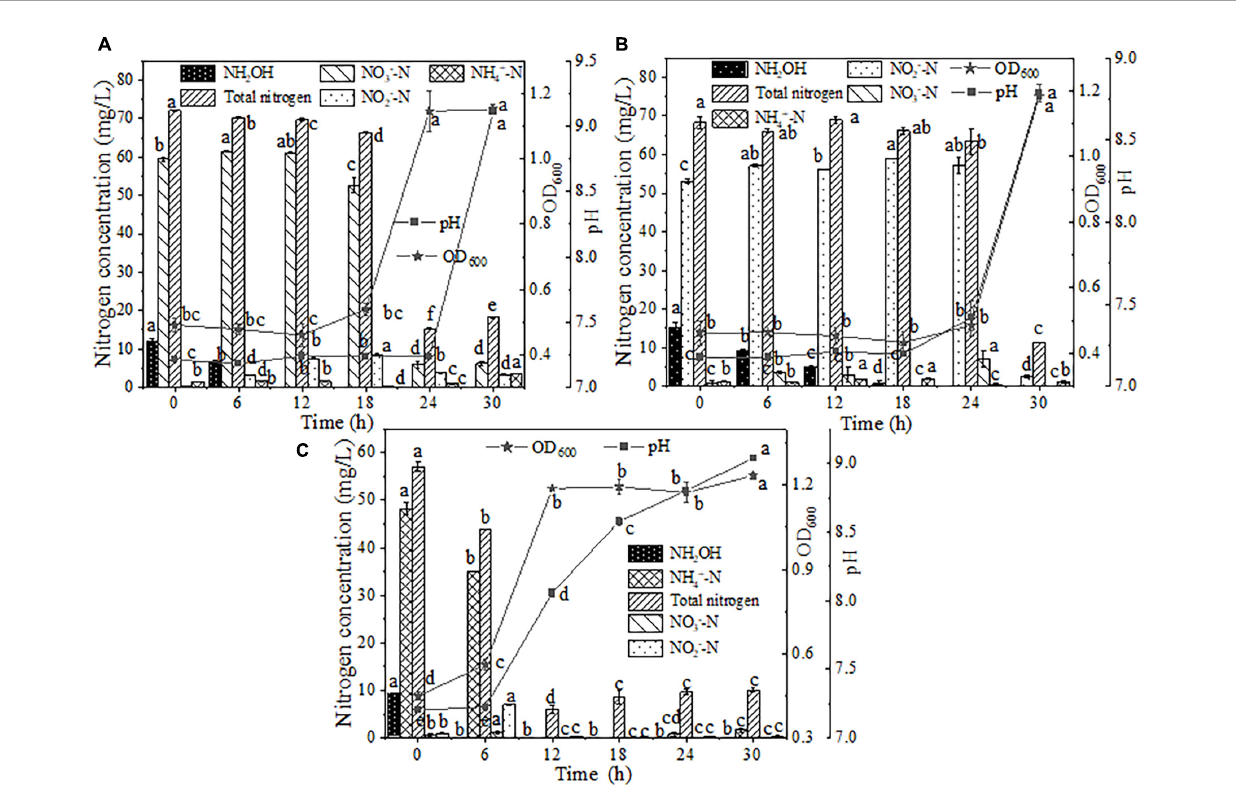
FIGURE5 The effects of hydroxylamine (NH 2 OH) on HN-AD. (A) Nitrate (NO 3 − -N); (B) nitrite (NO 2 − -N); (C) ammonium (NH 4 + -N). Different letters represent significant differences between treatments ( p < 0.05).